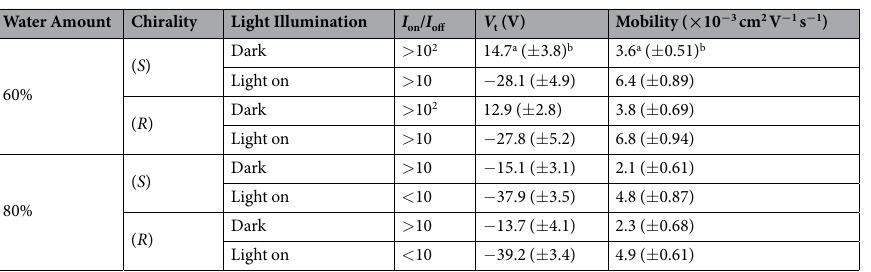
Table 1. Summary of the performances of ( S )-CPDI-Ph and ( R )-CPDI-Ph nanomaterials in THF/water mixed solution (1.0 × 10 − 5 M) with 60% and 80% of H 2 O. a The average values obtained for at least six devices from more than two different batches. b The standard deviation values obtained for at least six devices from more than two different